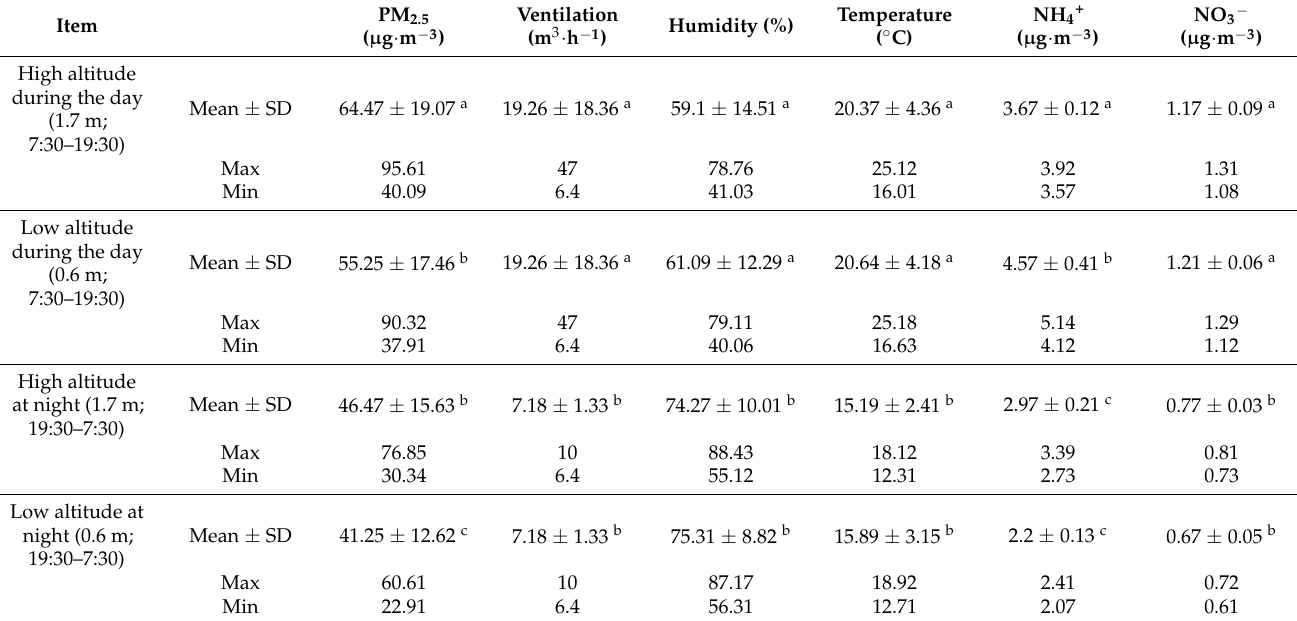
Table 2. Environment variables inside the pig house during the